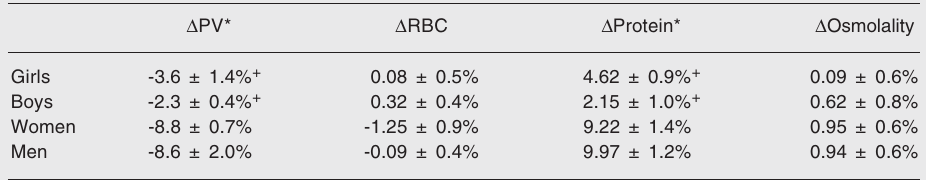
Data are reported in percent as means ± SEM. *Significant differences within each group (P < 0.05, ANOVA); + P < 0.05 compared to the respective adult group